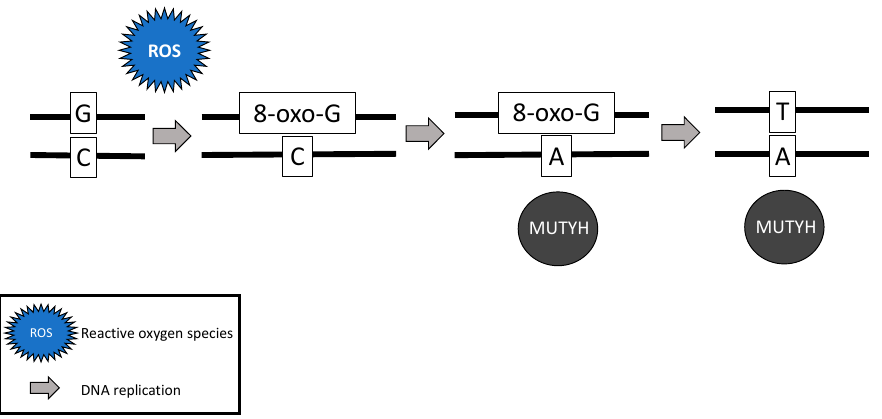
Figure 2. Failure of MUTYH ’s base excision repair mechanism and resultant G > T transversion.